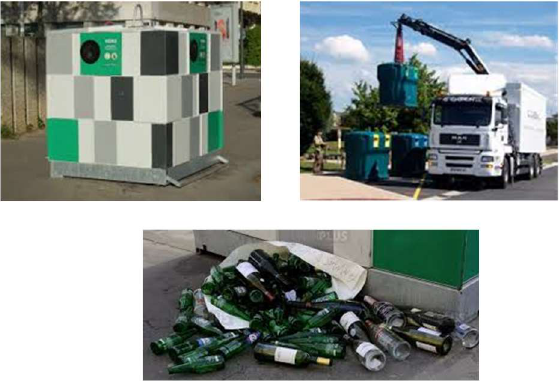
Figure 12. Bottle banks, collection and overflow.